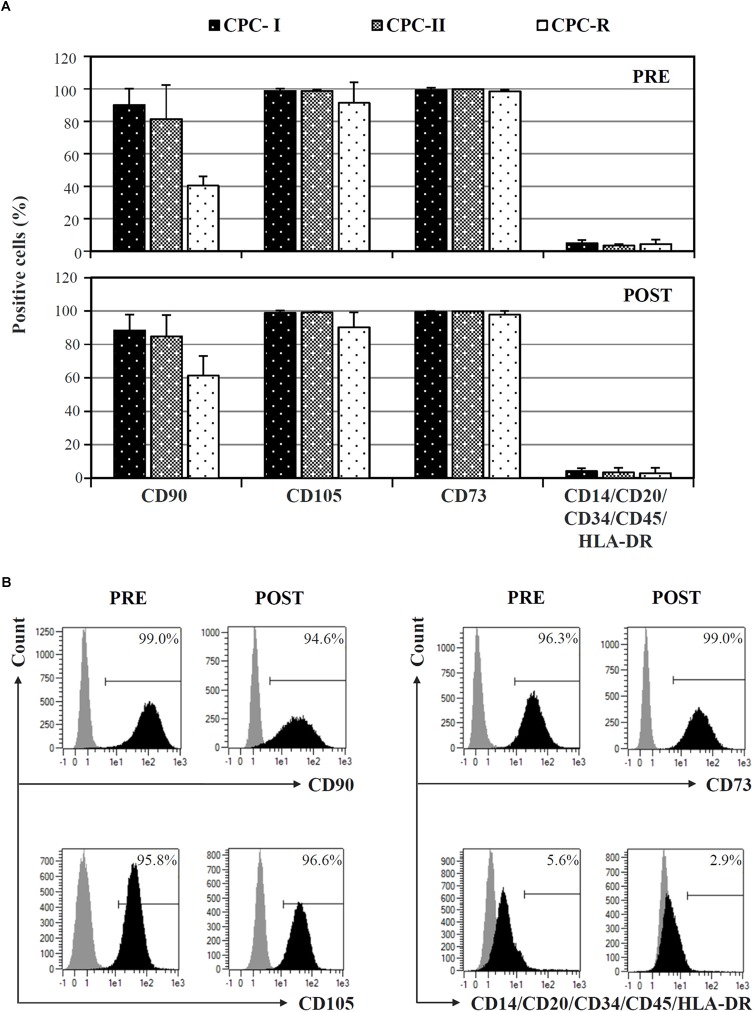
FACS analysis of CPC cultured in different conditions. (A) Comparison of surface markers expression on CPC cultured in GMP conditions (CPC-I and -II, n = 5) or research conditions (CPC-R, n = 3), before (PRE) and after (POST) 7-day in vitro starvation for Exo production. Bars: mean + SD. (B) Histogram plots of surface markers expression of CPC-I, before (PRE) and after (POST) starvation for Exo production. Gray peaks: staining with isotype control antibodies; black peaks: staining with antibodies specific for the reported markers.